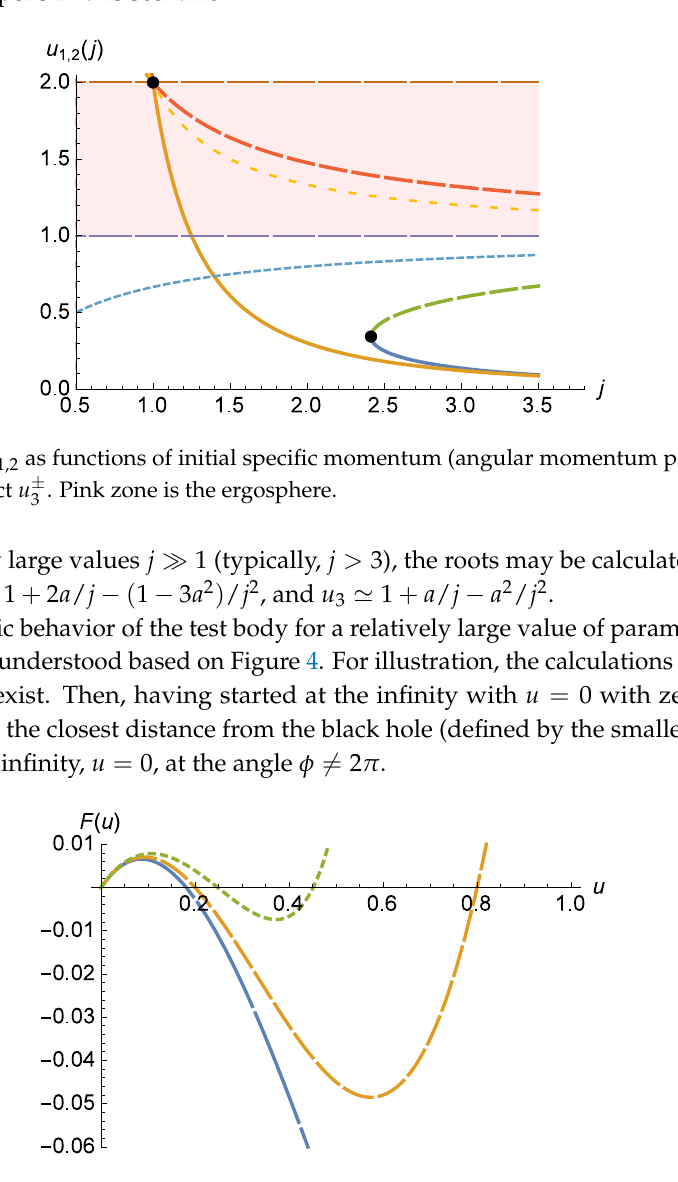
Figure 4. The right part of Equation (45) with j = 2.5 for values a = 0 (middle line, medium dashes), a = 0.49 (lower line, long dashes) and a = − 0.49 (upper line, short dashes). Motion of test body is possible in the domains where the root branches have positive